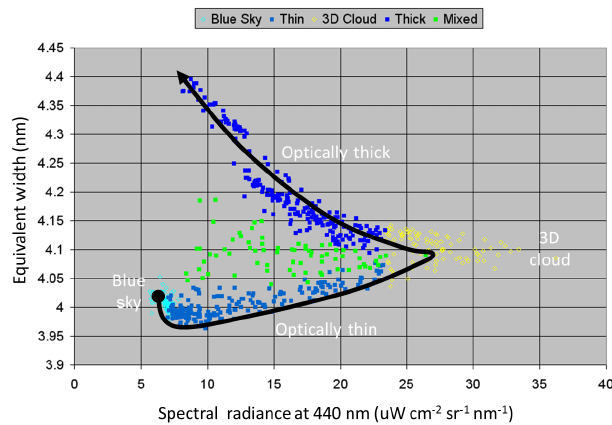
Figure 12. The “nose” plot of SR440 vs. EQW, indicating a trajec- tory with increasing COD. The data sample categories (colors) are described in the